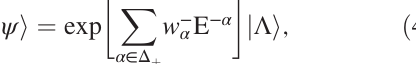
, depicted for a . Dashed lines a